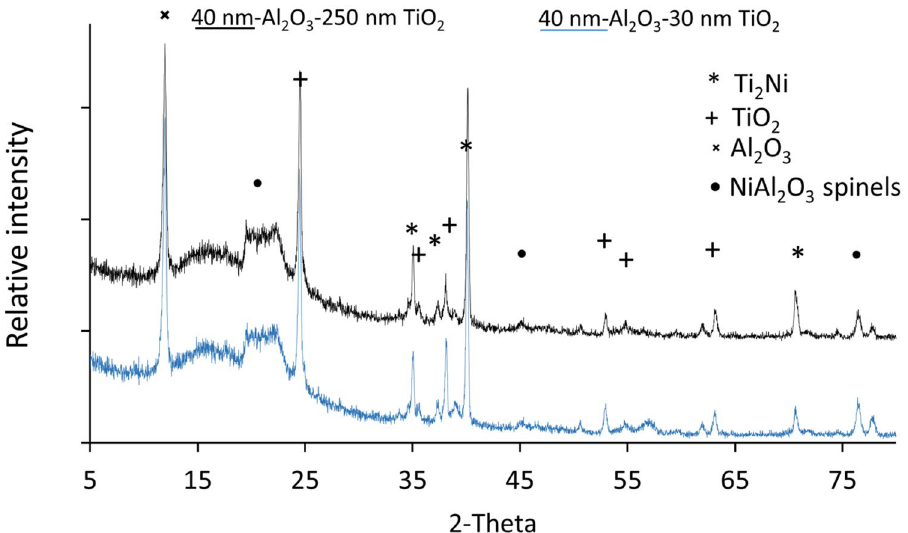
Figure 7. XRD analysis of the treated